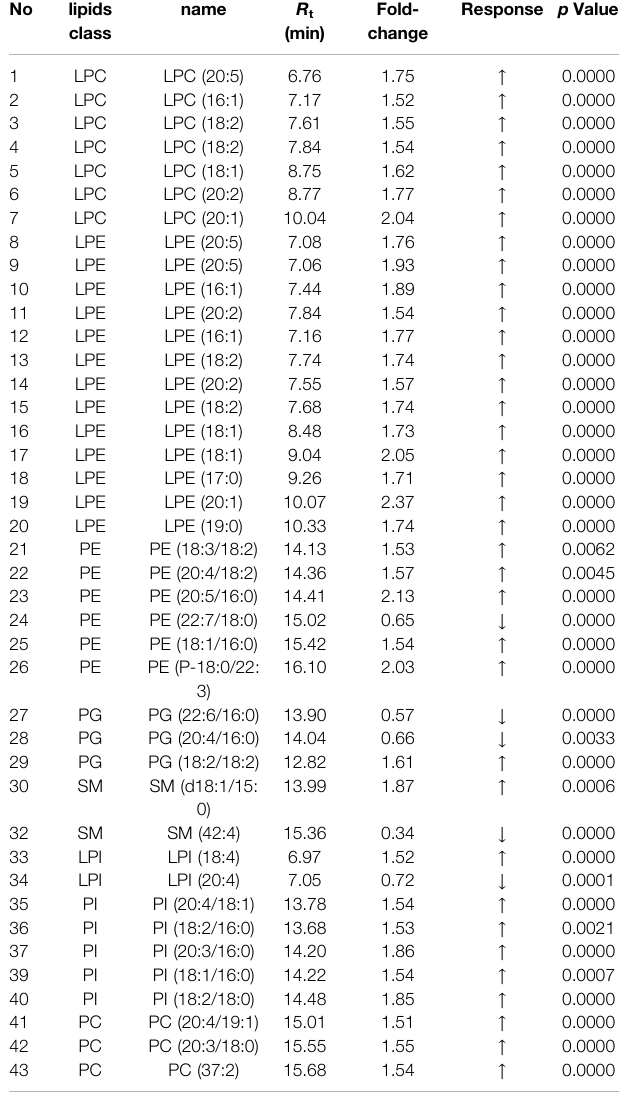
TABLE 3 | Signi fi cant changed lipids for F group vs. the model group (fold change > 1.5 and p < 0.001). No lipids